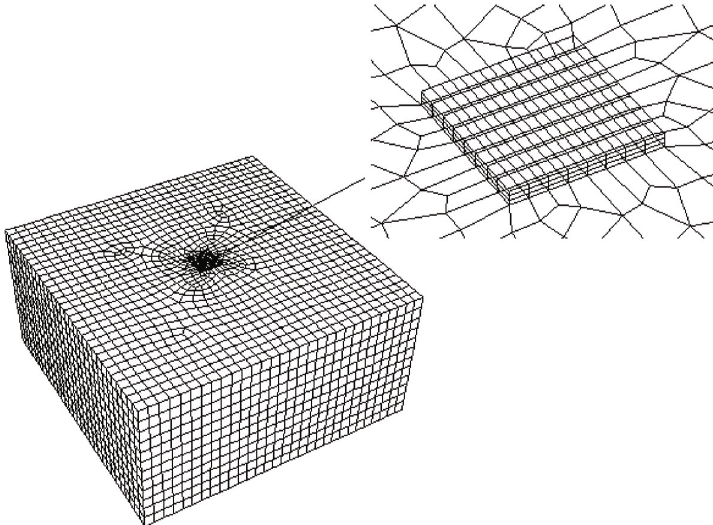
Figure 5: Mesh divisions for numerical analysis using the variable modulus constitutive model.